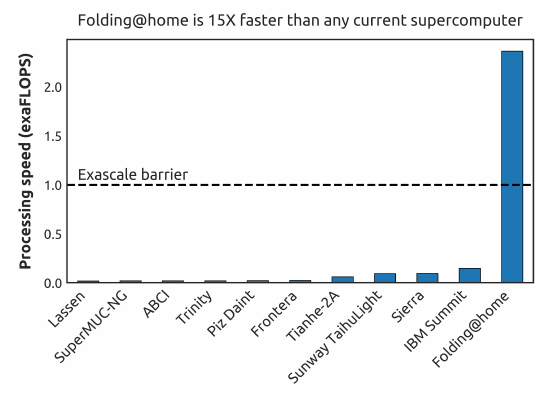
Figure 1. Processing speed posted by Folding@home project, 13 April 2020, https://twitter.com/ foldingathome/status/1249778379634675712.